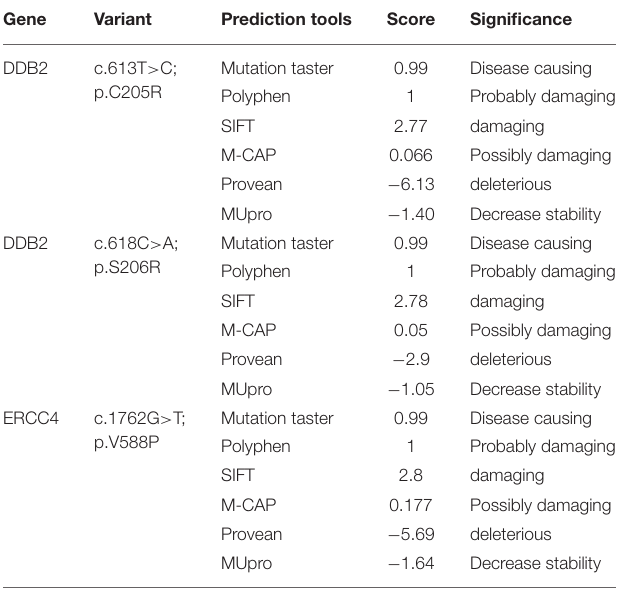
TABLE 2 | Prediction scores of the new detected variants in DDB2 and ERCC4 genes.